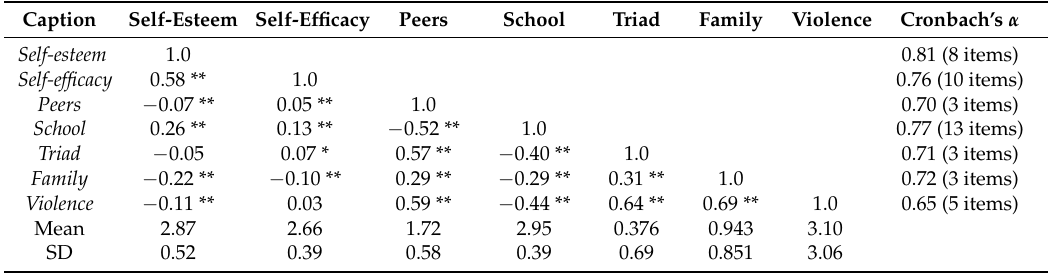
Table 2. Descriptive statistics, internal consistency reliability, and inter-variable correlations of all measurement scales.